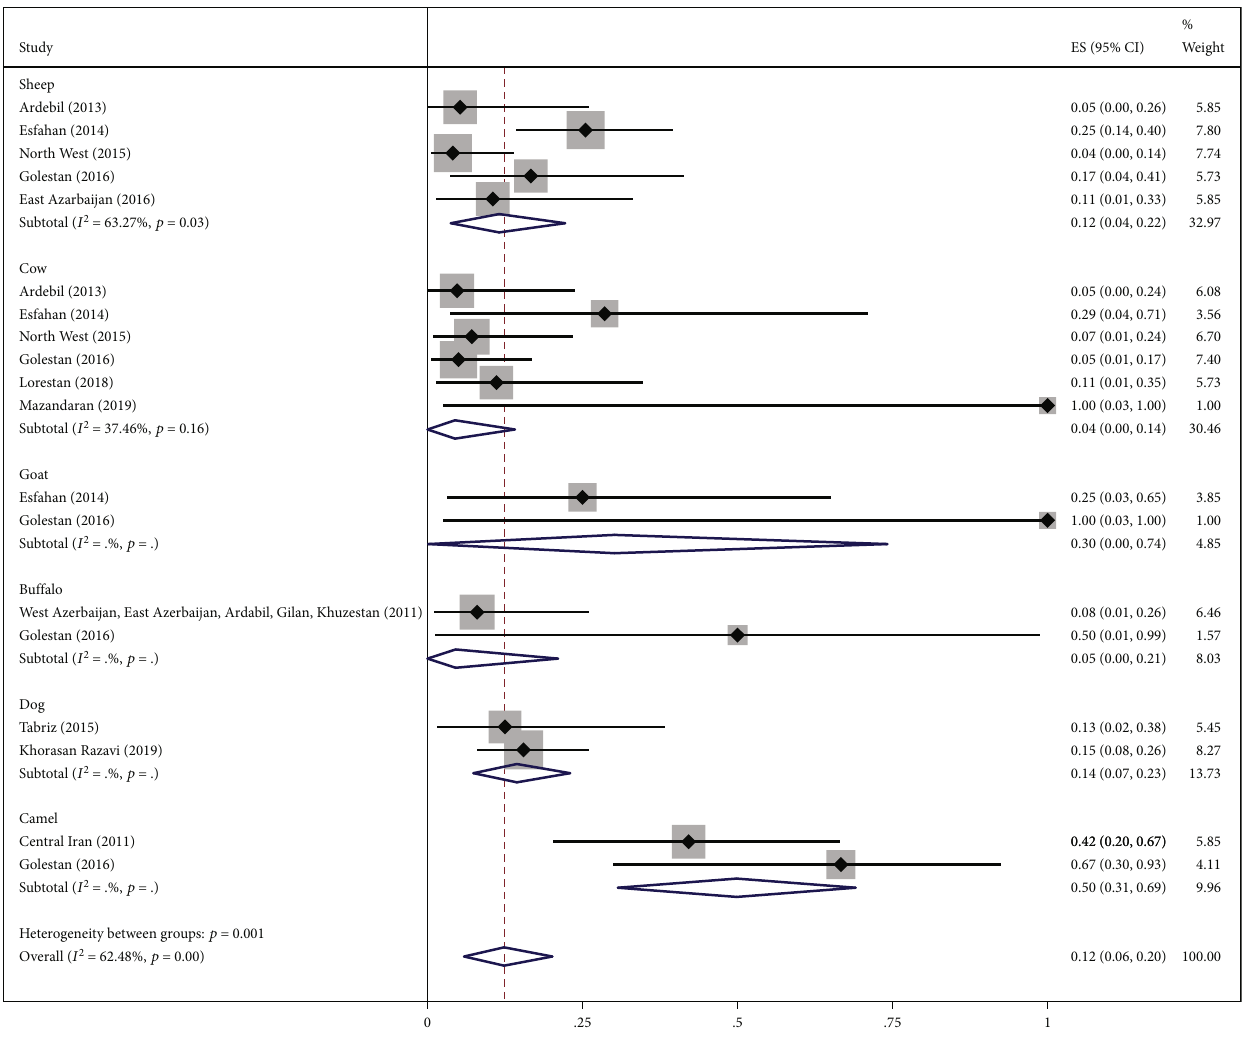
Figure 10: Forest plot of subgroup analysis of studies on cystic echinococcosis G